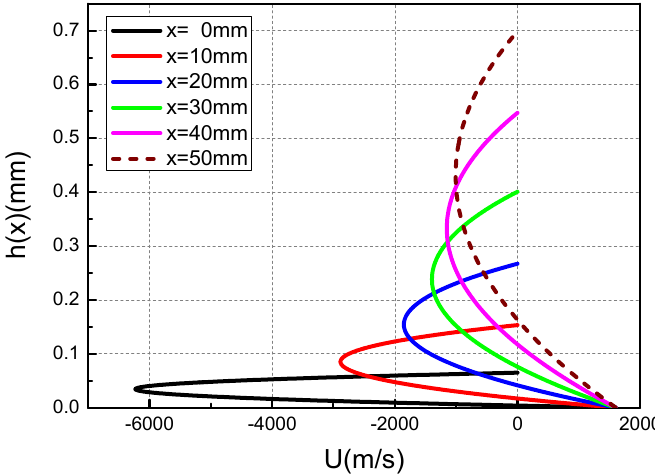
Figure 9. Velocity distribution curves of liquid film at different positions of the contact surface at U = 1600 m/s.